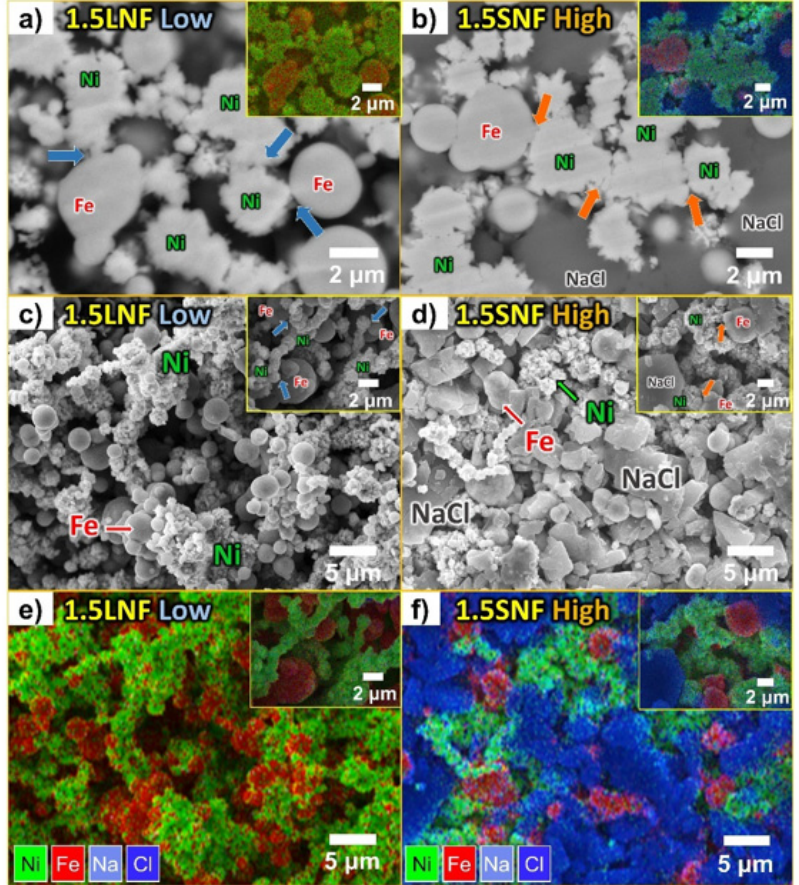
Figure 4. SEM images of cathode granules. ( a ) backscattering image for contacting Ni and Fe particles in 1.5LNF-low granules; ( b ) backscattering image for well-connected Ni and Fe particles in 1.5SNF-high granule; ( c , e ) microstructure of the 1.5LNF-low cell and Ni–Fe connections similar to those of the 2LN-low cell; ( d , f ) microstructure of the 1.5SNF-high cell and strong connections among Ni and Fe